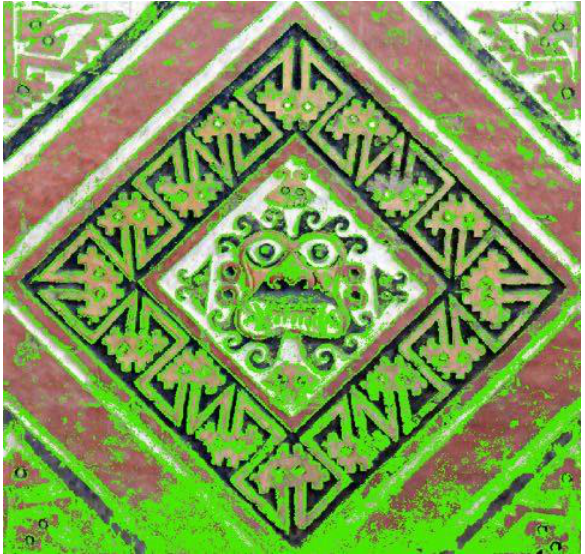
Figure 4. Result of per pixel subtraction between the data set of